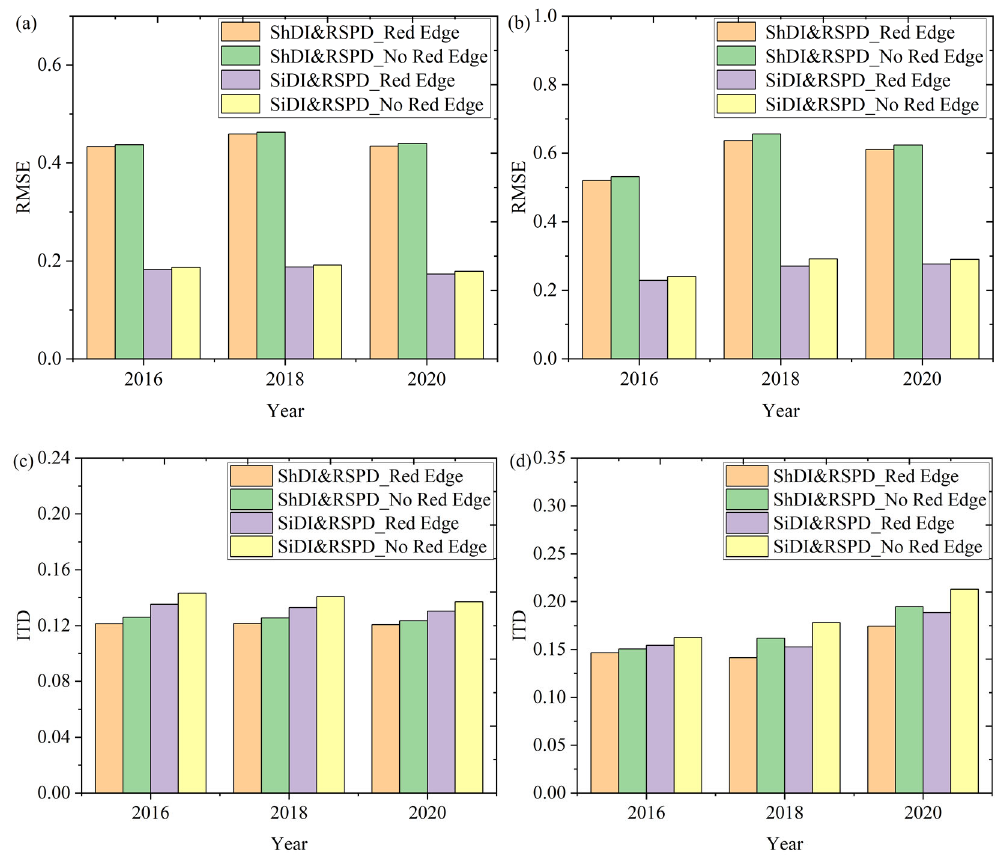
Remote Sens. 2021 , 13 , x FOR PEER REVIEW 17 of 23 Figure 13. Influence of red ‐ edge bands on RSPD effect (( a , c ) are Case I, ( b , d ) are Case II). Figure 13. Influence of red-edge bands on RSPD effect (( a , c ) are Case I, ( b , d ) are Case II).